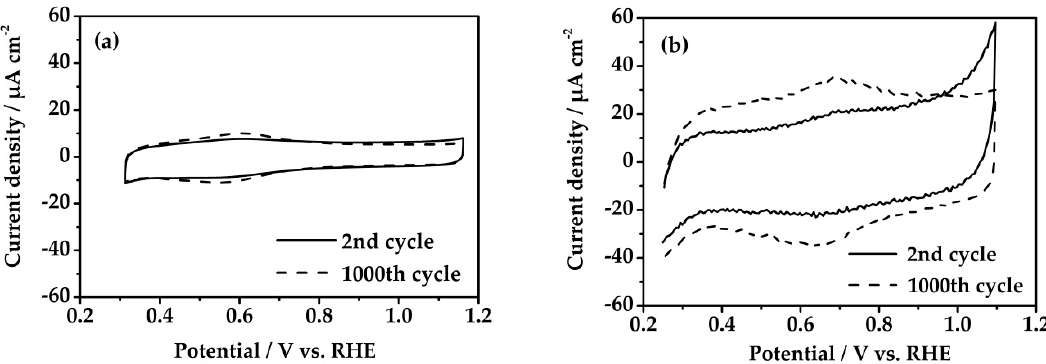
Figure 3. CVs of pre-activated BPPs in 15 M H 3 PO 4 at 10 mV s − 1 performed in experimental ( a ) set-up A and ( b ) set-up B. The second and 1000th cycles are shown.